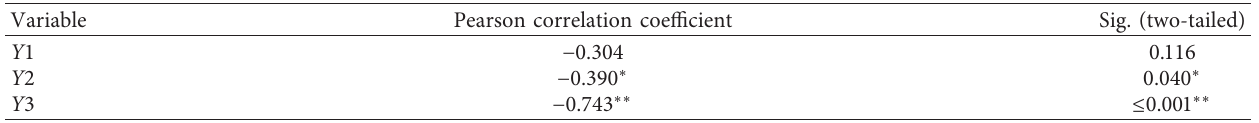
Table 5: Results of the Pearson correlation analysis of the pandemic disaster severity and urban